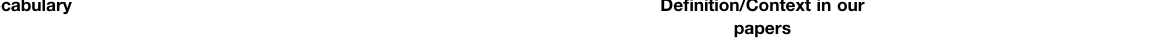
TABLE 1 | Smart gait